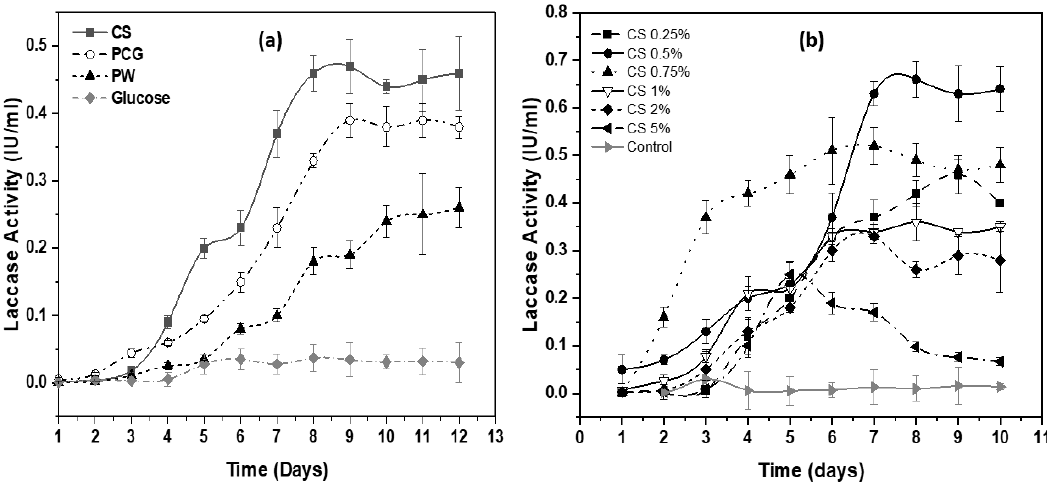
Figure 1. ( a ) Effect of agro-wastes as substrates on laccase production. ( b ) Effect of varying CS concentrations on laccase production in Geobacillus sp. strain WSUCF1 at 60 °C, pH 7.0, and agitation speed of 150 rpm, after 10 days of incubation. Here, CS = Corn stover; PCG = Prairie cordgrass; PW = Pinewood; IU = International Units. Note: All the experiments were performed in triplicates, with data averaged and presented as the mean ± standard deviation (SD).